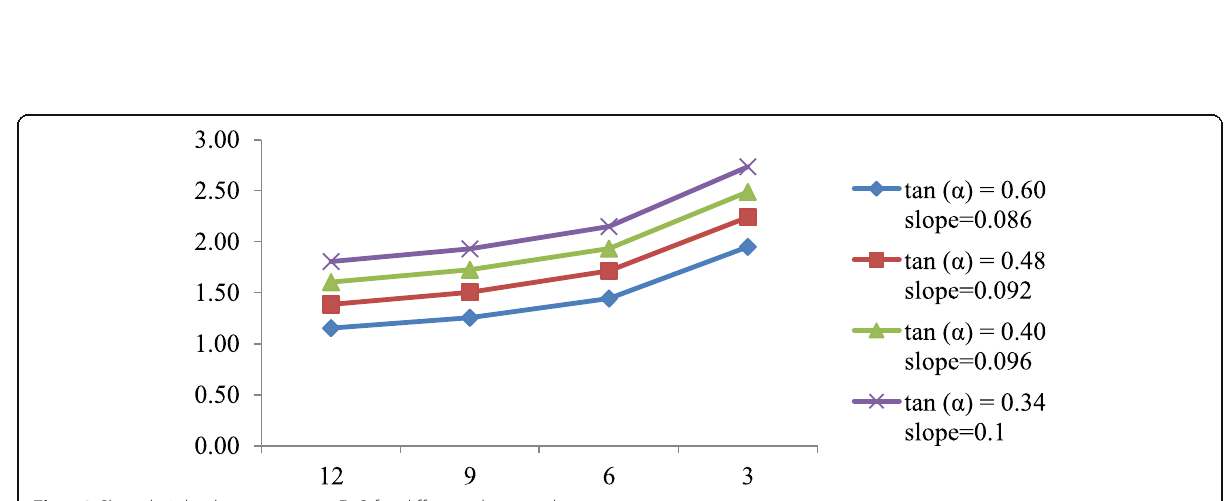
Fig. 13 Slope height decrease versus FoS for different slope